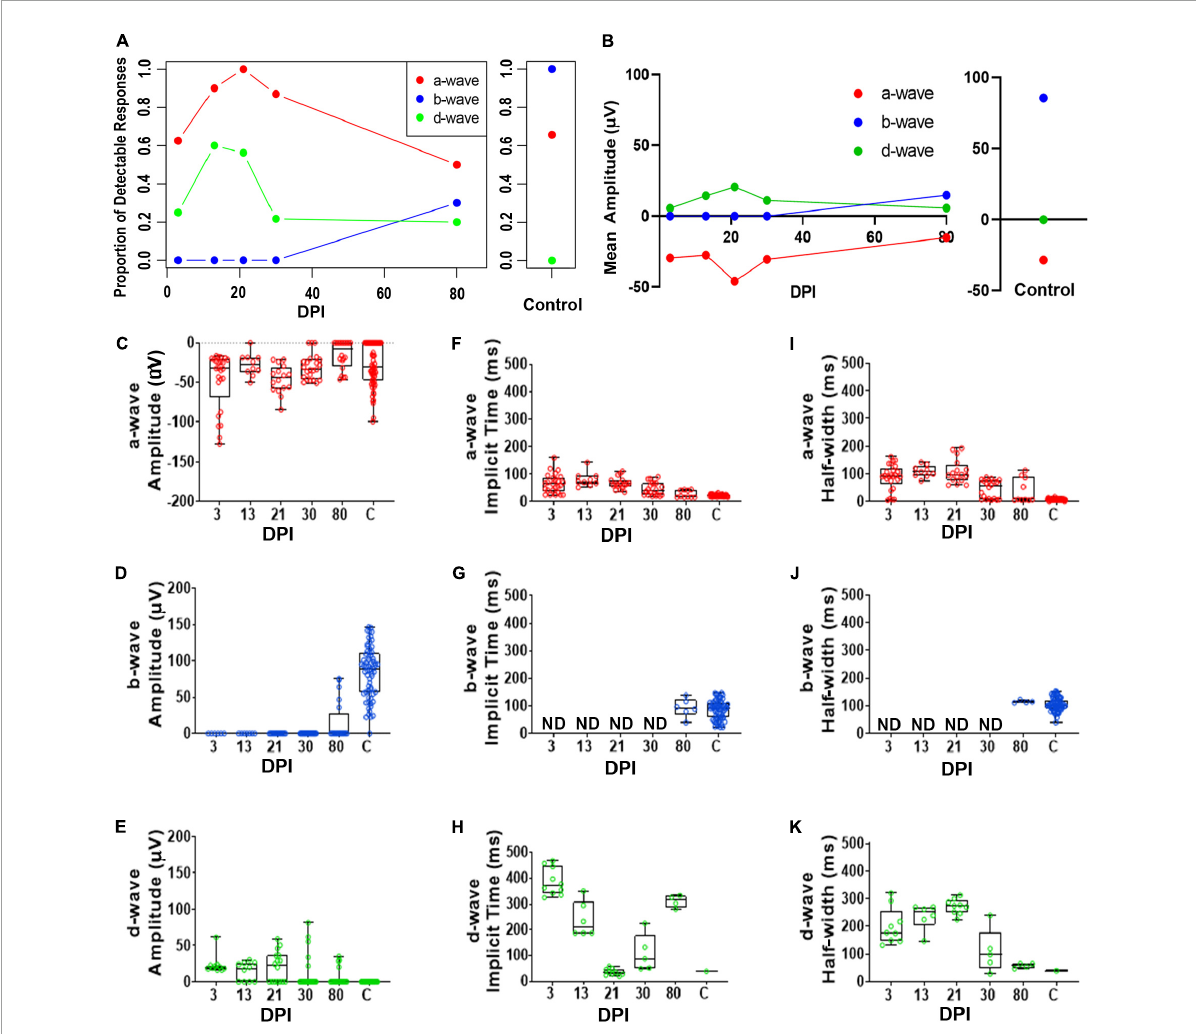
FIGURE5 Quantitative analyses of identified a-, b-, and d-waves over a regeneration time-course following a selective lesion. (A) Proportion of detectable responses ( > 15 µ V deflections) recorded for apparent a-waves (red filled circles; defined as negative deflections during 0-100 ms of light stimulus), b-waves (blue filled circles; positive deflections during 0-100 ms stimulus), and d-waves (green filled circles; positive deflections after end of stimulus, 200-500 ms), over regeneration time-course for selective lesion, and for contralateral, unlesioned control eyes. (B) Average peak amplitudes of a-, b- and d-waves over regeneration time-course, and for contralateral, unlesioned control eyes. (C–E) Peak amplitudes of a-waves (C) , b-waves (D) , and d-waves (E) . (F–H) Implicit times of a-waves (F) , b-waves (G) , and d-waves (H) . (I–K) Half-widths of a-waves (I) , b-waves (J) , and d-waves (K) . Each symbol represents a value for an individual eye, the horizontal band represents the median, the top and bottom of each box (where present) indicate the 75th and 25th percentiles, and the whiskers represent the maximum and minimum. DPI, days post-injury; ND, not